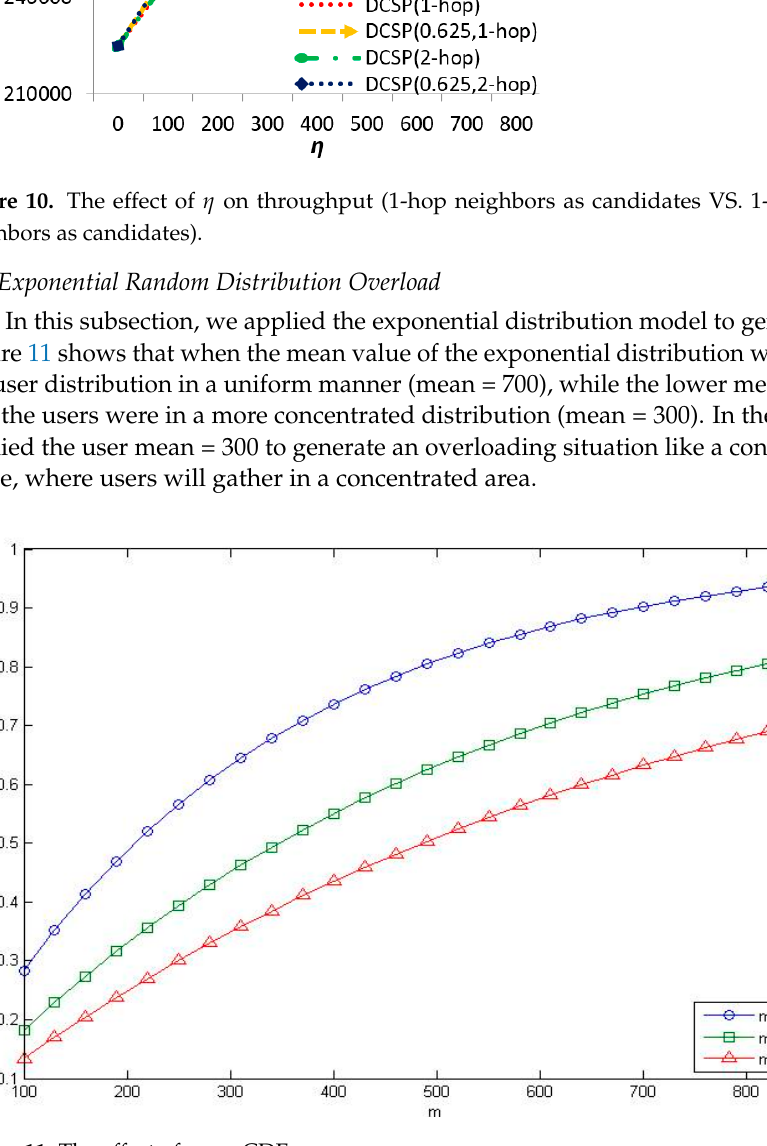
Figure 10. The effect of η on throughput (1-hop neighbors as candidates VS. 1-hope and 2-hop neighbors as